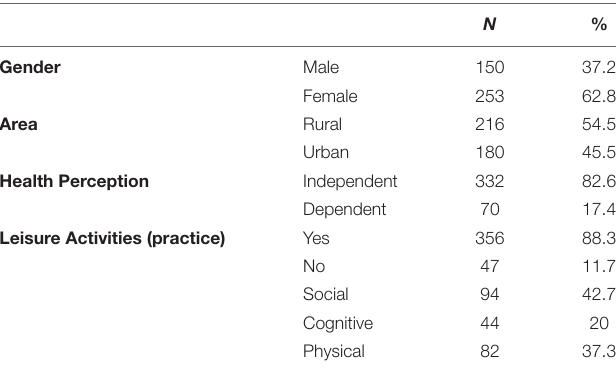
TABLE 1 | Sociodemographic characteristics ( N =